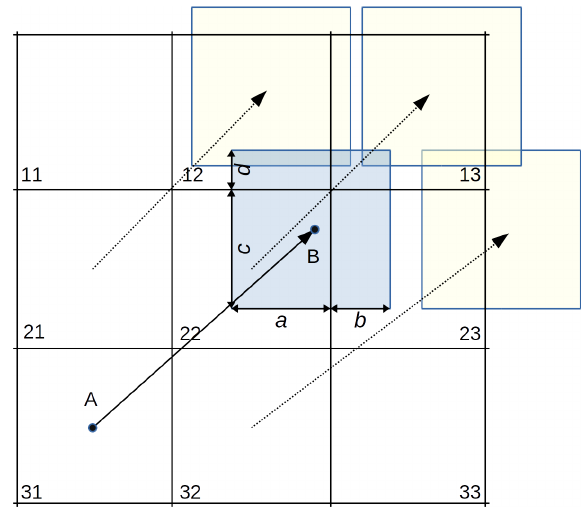
Figure 2. Scheme of Eulerian advection of sea ice. Points A and B denote start and end of drift of an ice parcel shown by the blue